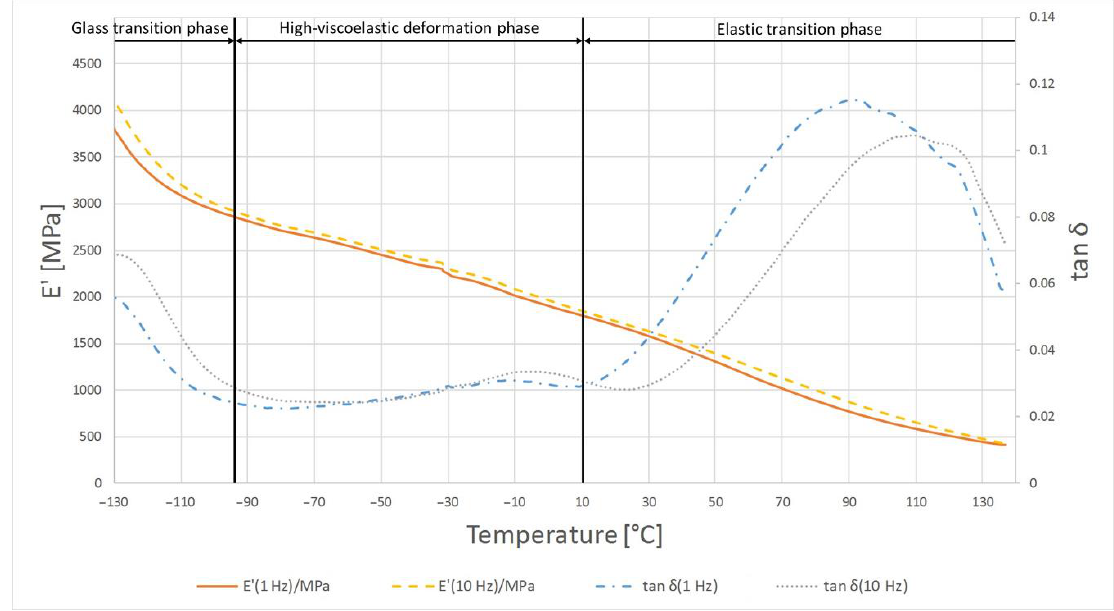
Figure 7. Results of DMTA test for PE1000 after heat treatment.